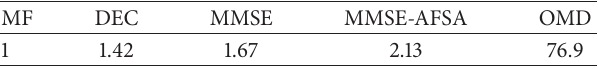
Figure 5: The near-far resistance of different detectors. Table 2: Relative computational complexity of different detectors.